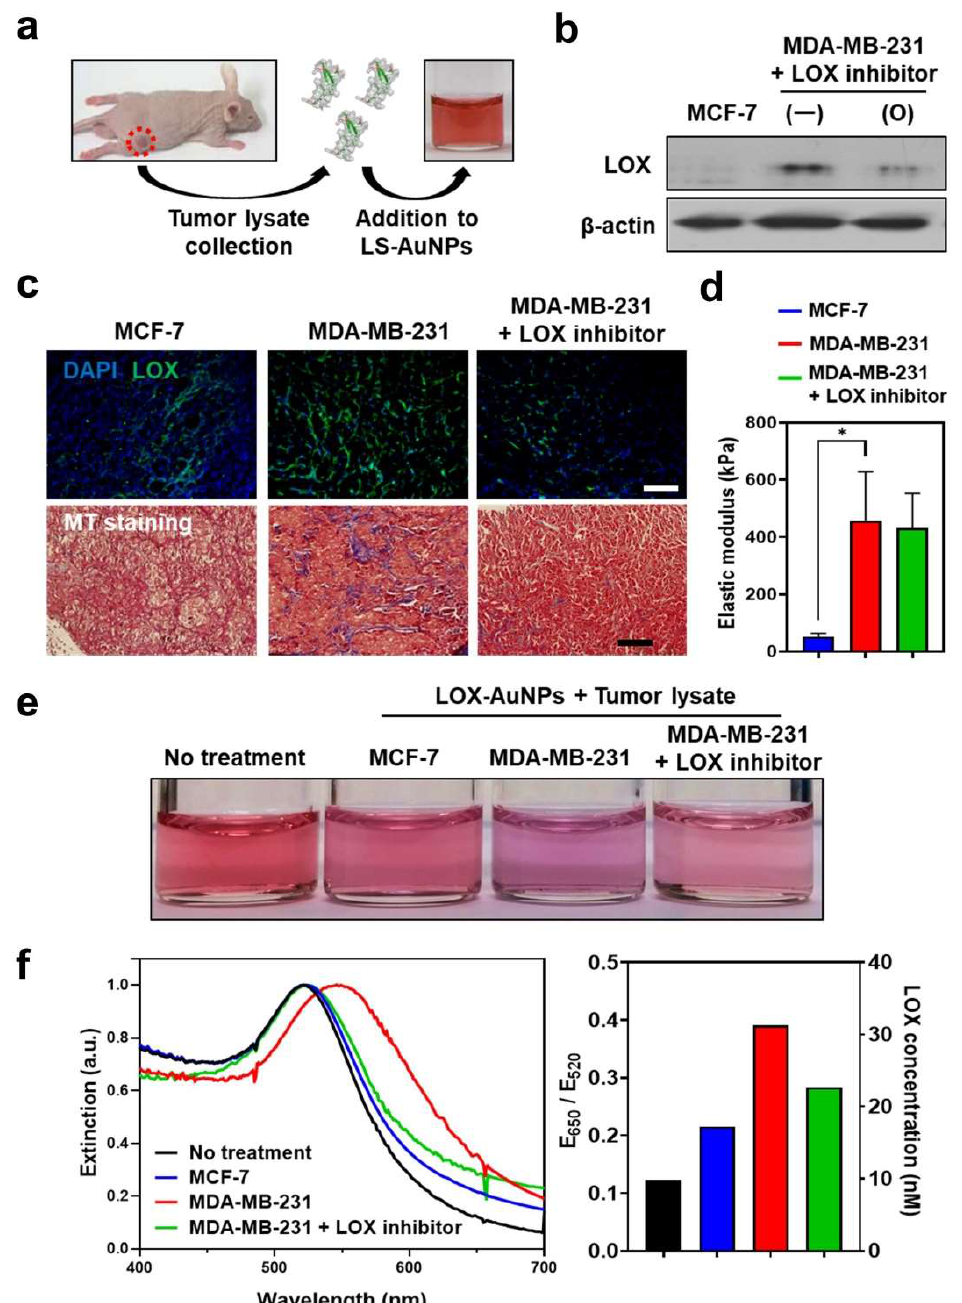
Figure 6. ( a ) Schematic illustration of the addition of tumor lysates collected from MCF-7 (low LOX expression) or MDA-MB-231 (high LOX expression) tumor-bearing mice to LS-AuNPs for the detection of the LOX level in tumor tissues. ( b ) Western blot analysis for the evaluation of LOX protein in tumor tissues of MCF-7- and MDA-MB-231-bearing mice with or without treatment with LOX inhibitor. Original Western Blot figure can be found in Supplementary Materials. ( c ) IHC staining of LOX (upper panel) and Masson′s trichrome (MT; lower panel) staining of tumor tissues from different experimental groups. ( d ) Measurement of elastic modulus to compare the stiffness of different tumors. Asterisk indicates significant difference (* p < 0.05). ( e ) Photographs of LS-AuNP suspension before or after the addition of the tumor lysates collected from different animal groups. ( f ) UV/Vis extinction spectra (left panel) and E 650 /E 520 value (right panel) of the LS-AuNPs suspension treated with various tumor lysates.